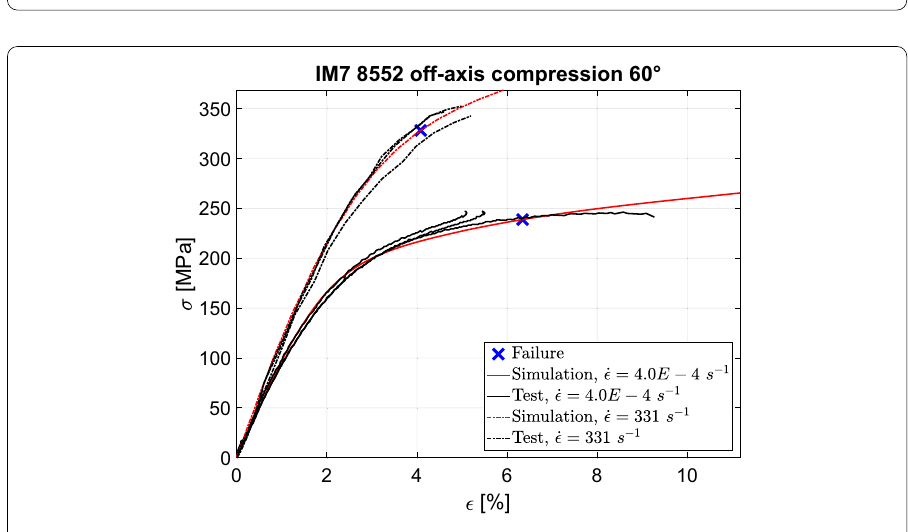
Fig. 19 True stress–true strain curves for the compression tests and simulations, 60 ◦